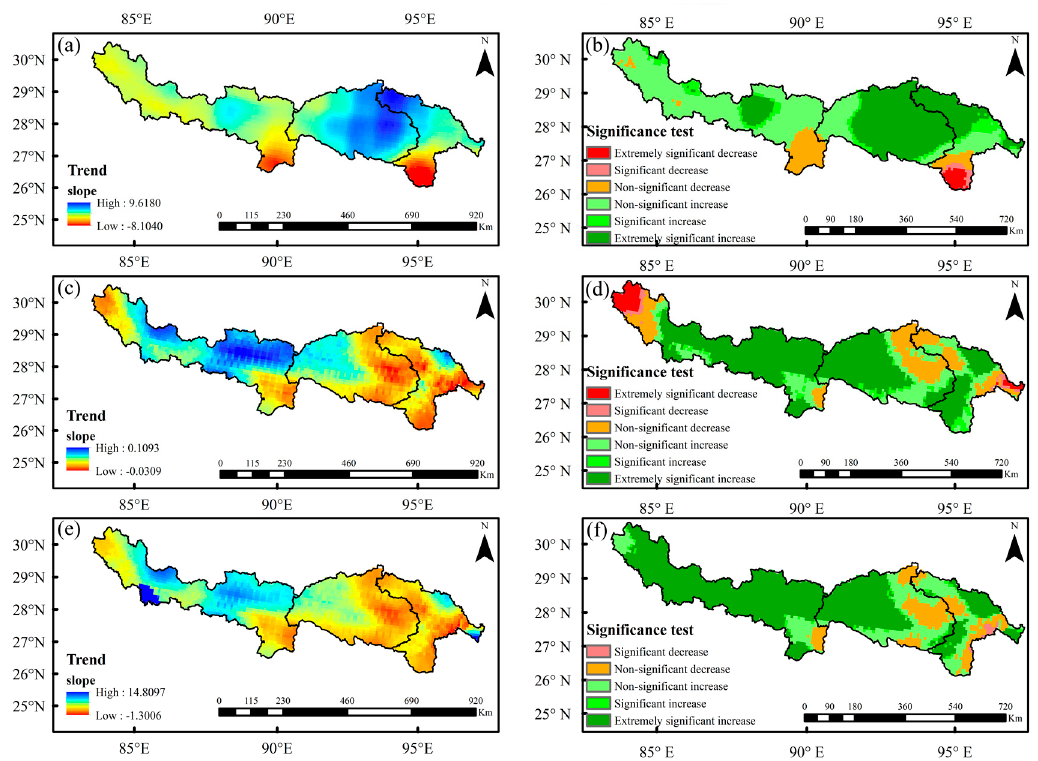
Figure 17. Analysis on the spatial variation trends of the growing season precipitation ( a, b ), ( c, d ), and PET ( e, f ) with the significance temperature ( c, d ), and PET ( e, f ) with the significance test.